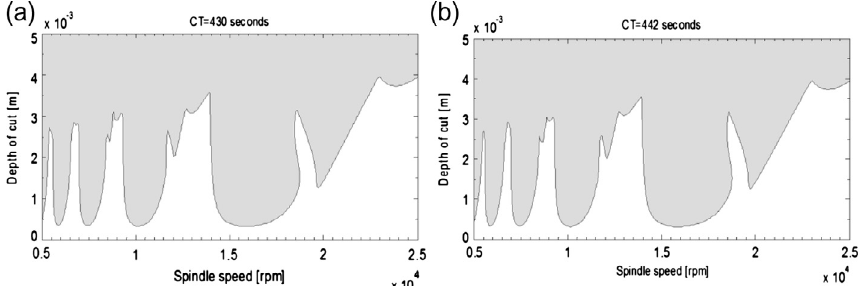
Figure 6. Stability lobes of fully-immersed 1DOF milling process using (a) Second Order Least Squares Approximated Full-discretization method with Partial averaging (CT = 430 s) and (b) the original Second Order Least Squares Approximated Full-discretization method presented in [18] (CT = 442 s). Very good agreement between the two verifies reliability in terms of accuracy of using PA in the Full- discretization